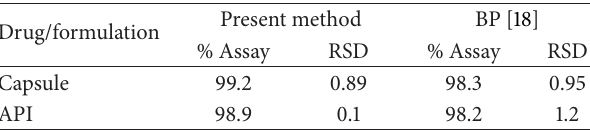
Table 7: Assay of marketed pharmaceutical formulation and